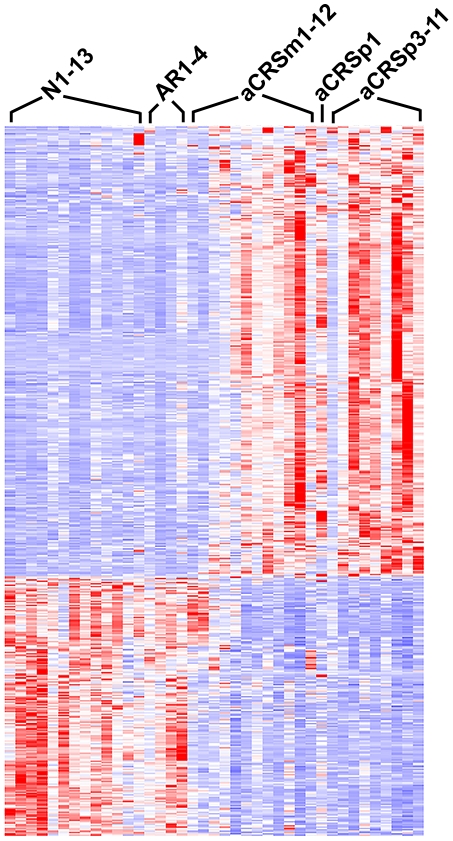
Heat Map Profiles of the 39 Nasosinus Tissue Specimens Analyzed by Exon Array.Each horizontal bar represents 1 of the 528 genes identified as differentially transcribed between clearcut Normal samples (N1 to N8) and clearcut aCRS polyp samples (aCRSp3 to aCRSp11). The bar color indicates the relative transcription level from blue (low) through white to red (high). Inflamed mucosa samples are indicated by “m”, and aCRSm12 was a small sample of mixed inflamed mucosa and polyp. The inflamed mucosa (m) and polyp (p) aCRS samples with the same ending number are from the same donor.